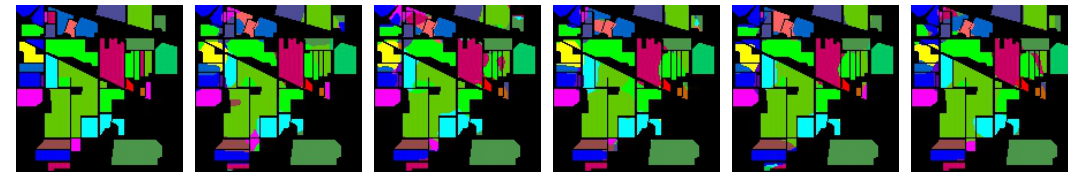
Figure 4. Classification maps on Indian Pines. The first map is the groundtruth. The rest ones are predicted by our employed classifier with the random sampling, the least confidence, the entropy sampling, bayesian active learning disagreement (BALD), and our adversarially learned acquisition heuristic (i.e., our FAAL framework), separately. Table 2 lists what class each color represent. Specifically, the part in black means unlabeled.